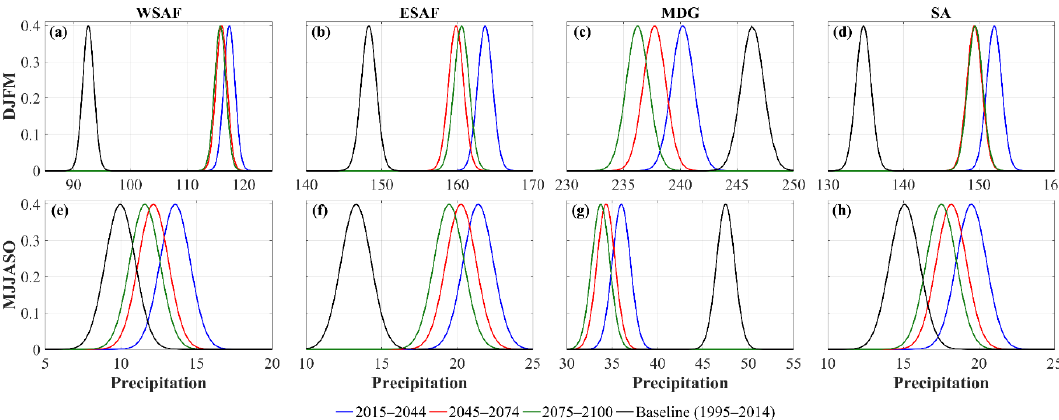
Figure 11. Probability density distribution of seasonal precipitation (mm) under SSP2-4.5 emission scenario, averaged over ( a , e ) WSAF, ( b , f ) ESAF, ( c , g ) MDG and ( d , h ) SA, for ( a – d ) DJFM and ( e – h ) MJJASO seasons. The blue, red, green and black